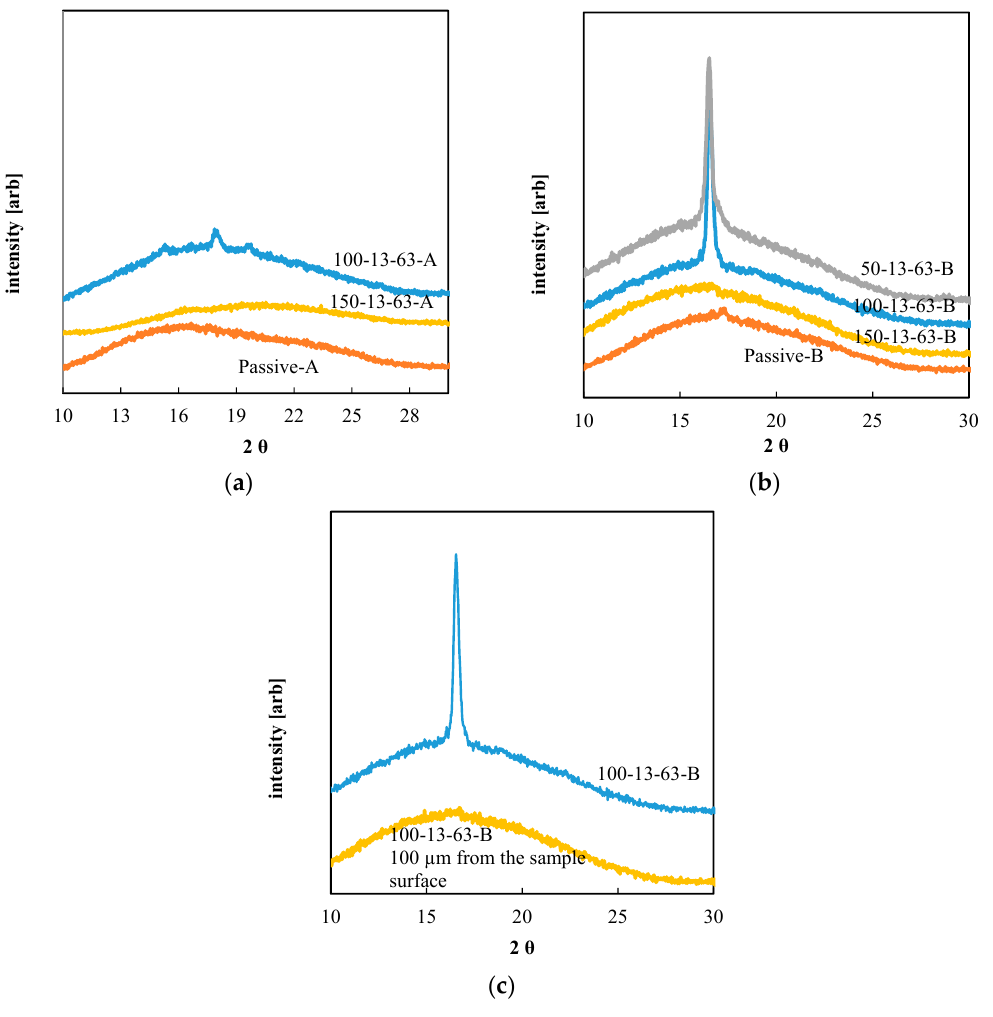
Figure 13. X-ray Diffractometry (XRD) spectra of the PLA injection-molding samples ( a ) PLA3251D, and ( b ) PLA4032D. ( c ) XRD spectra along the sample thickness for the sample 100-13-63-B.